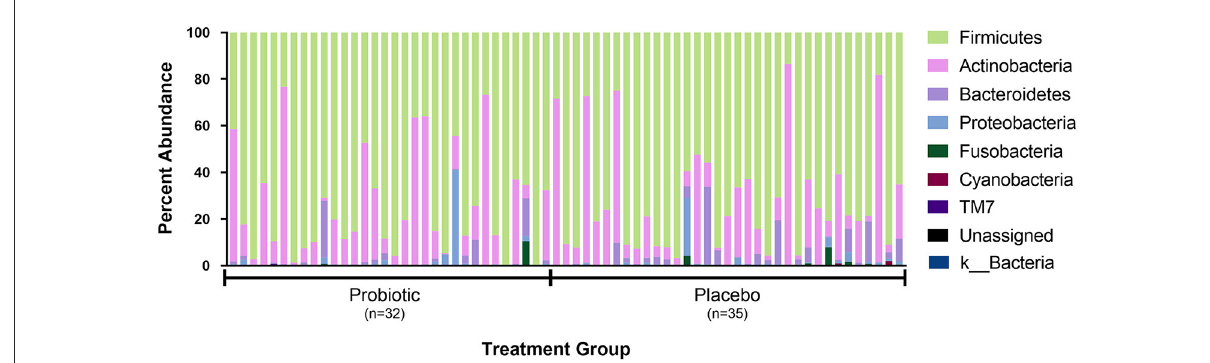
FIGURE3 Percent abundance of the major phyla observed in feces from 67 individual kittens. Each sample is designated as having been obtained from a kitten receiving either the probiotic or placebo. Not shown in legend are phyla observed in < 10 kittens and at an abundance < 0.15% in all